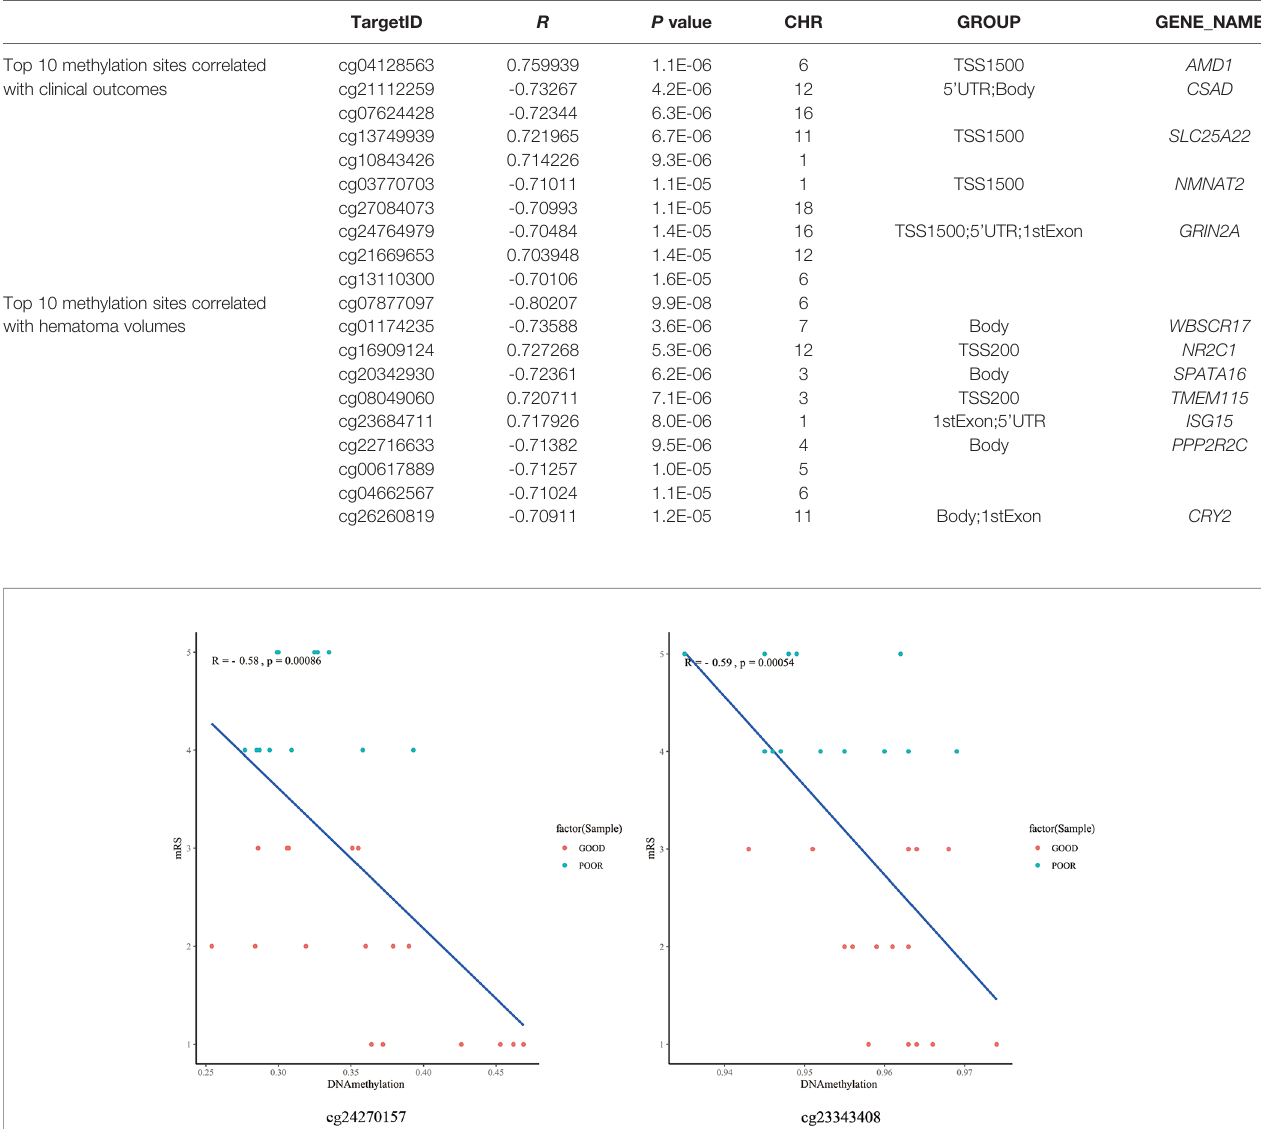
TABLE 4 | Top 10 methylation sites correlated with clinical outcomes and hematoma volumes.